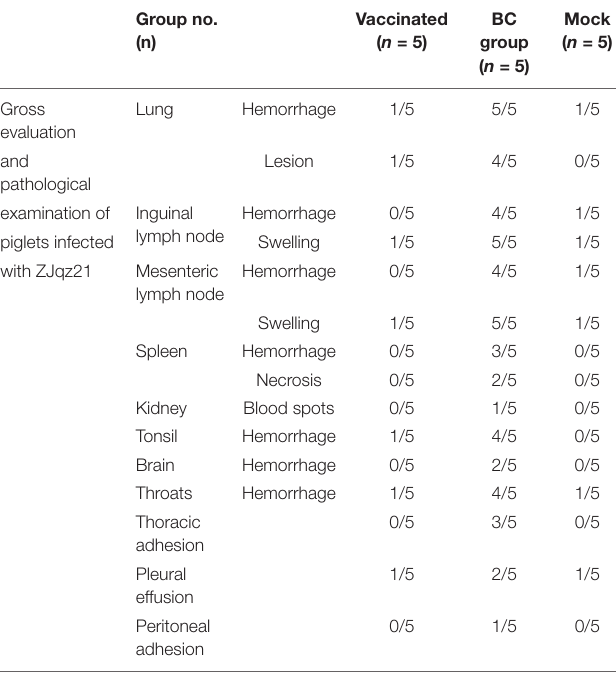
TABLE 4 | Gross evaluation and pathological examination of piglets in three groups. Group no. (n)